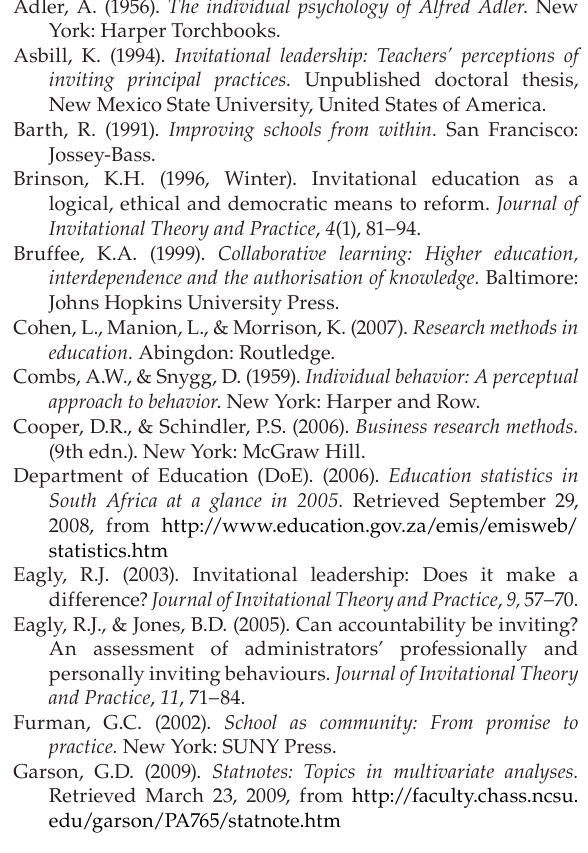
Similarities between the ‘Four Corner Press’ and South African teachers’ expectations of invitational leadership 'Four Corner